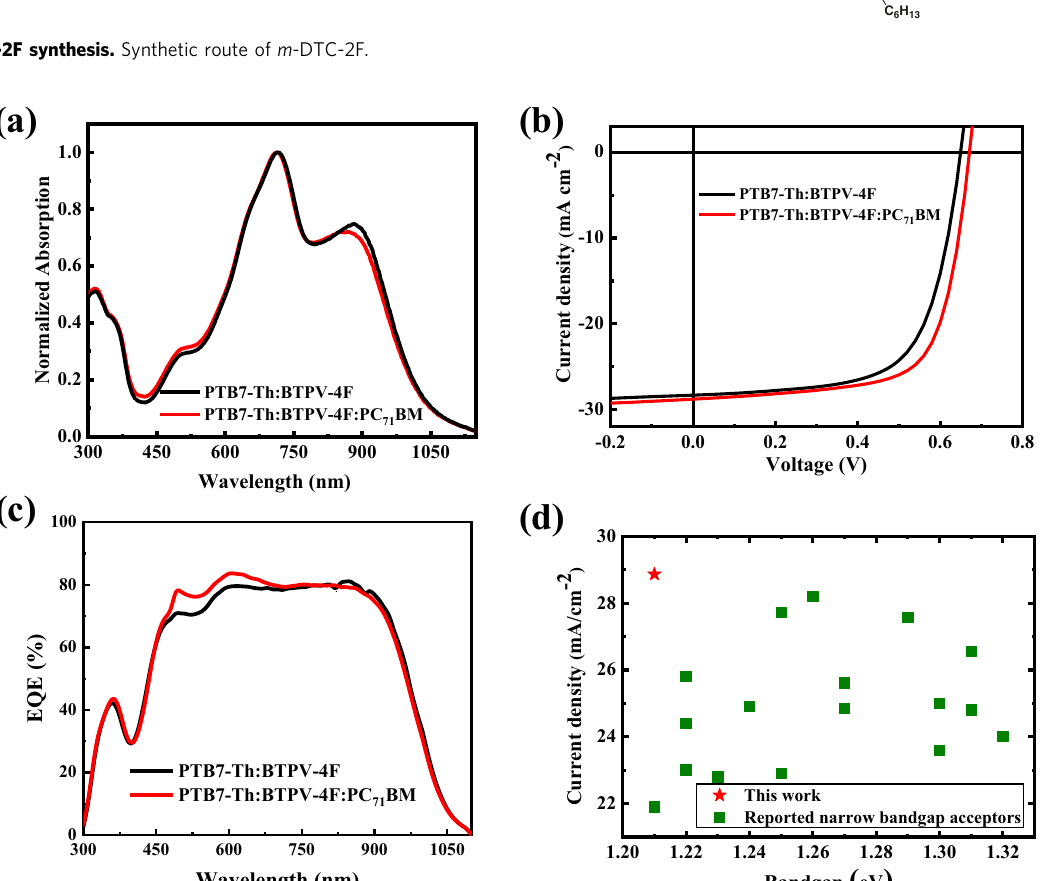
Fig. 4 Absorption spectra and photovoltaic performance of PTB7-Th:BTPV-4F. a Normalized absorption spectra of blend fi lms of PTB7-Th:BTPV-4F (1:1.5, w/w) and PTB7-Th:BTPV-4F:PC 71 BM (1:1.5:0.15, w/w/w). b The J – V curves of the optimized binary OSC based on PTB7-Th:BTPV-4F(1:1.5, w/w) and ternary OSC based on PTB7-Th:BTPV-4F:PC 71 BM (1:1.5:0.15, w/w/w). c The EQE spectra of the corresponding binary and ternary OSCs. d Plots of J sc values of the OSCs vs. optical bandgaps of the narrow bandgap acceptors used in the OSCs reported in the literature and from this work with the acceptor of Photovoltaic properties of narrow bandgap acceptor BTPV-4F . in Table 1. The binary OSC based on PTB7-Th:BTPV-4F shows a PCE of 12.1% with a V oc of 0.65 V, a high J sc of 28.3 mA cm − 2, and an FF of 65.9%. After introducing PC 71 BM as the third component, the best PCE of the ternary OSC based on PTB7-Th:BTPV-4F: PC 71 BM with a weight ratio of 1:1.5:0.15 reached 13.4% with FF of 69.3%, compared to those of the binary device. The enhanced V oc could be due to the reduced nonradiative recombination loss by introducing PC 71 BM, which can be widely observed in OSCs based on acceptors with the BTP central core 47 . The EQE spectra of the BTPV-4F active layer and 1:1.5:0.15 for the ternary PTB7-Th: binary and ternary devices are shown in Fig. 4c. The two optimized BTPV-4F:PC 71 BM active layer. Figure 4a shows the absorption spectra of the blend fi lms of PTB7-Th:BTPV-4F (1:1.5) and PTB7- devices both show ef fi cient and broad photon ‐ to ‐ electron response Th:BTPV-4F:PC 71 BM (1:1.5:0.15). The blend fi lms exhibit strong range from 300 to 1050 nm, which is consistent with the absorption absorption in the NIR region. The fabrication conditions of the spectra of the blend fi lms, and exhibited high EQE response in the OSCs were optimized and the results are listed in Supplementary NIR region. The integrated J sc from the EQE spectra of the binary and ternary devices are 27.83 and 28.31 mA cm − 2 , respectively, which is in good agreement with the J sc values measured from the J – V curves within 2% mismatch.